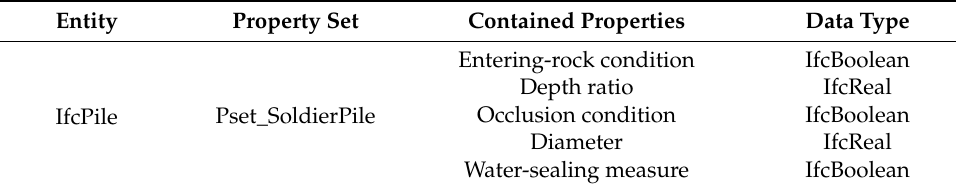
Figure 5. IfcPile with increasing property set. Table 3. Property set extension of IfcPile